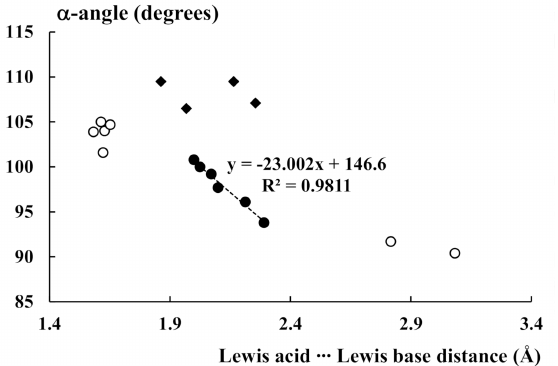
Figure 6. The dependence between the Lewis acid ··· Lewis base distance, T ··· B, (Å) and the α -parameter (see Scheme 1) in A-T ··· B triel bonds (T-triel centre). Black and white circles correspond to the neutral complexes, aluminium and boron species, respectively. Squares correspond to anion